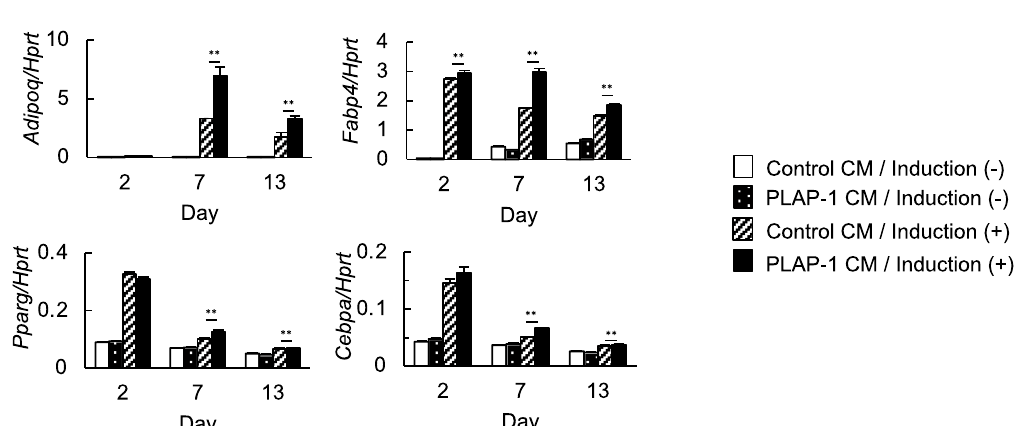
Figure 5. Adipocyte differentiation of 3T3-L1 cells in the presence of recombinant PLAP-1. ( A ) PLAP-1 expression in culture supernatants from 3T3-L1 cells infected with adenoviruses that carried LacZ or mouse Plap-1 was identified by Western blot analysis. Total protein level was shown by Ponceau S. Control CM: Control conditioned medium infected with adenoviruses that carried LacZ , PLAP-1 CM: PLAP-1 conditioned medium infected with adenoviruses that carried Plap-1 . The original blot images are included in Fig. S4. ( B ) Oil Red O staining of 3T3-L1 cells in the presence of recombinant PLAP-1 was conducted after adipocyte differentiation. ( C ) Quantitative lipid assay of 3T3-L1 cells in the presence of recombinant PLAP-1 was performed after Oil Red O staining ( n = 4). Values represent the mean ± SD. ( D ) Real-time PCR analysis was performed to examine adipogenic related gene expression of 3T3-L1 cells in the presence of recombinant PLAP-1 during adipocyte differentiation (n = 3). Results show the mean ± SD of triplicate assays. *: p < 0.05, **: p <